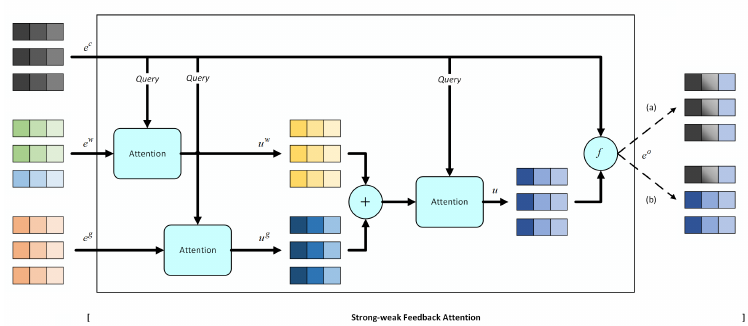
Figure 2. Strong–weak Feedback